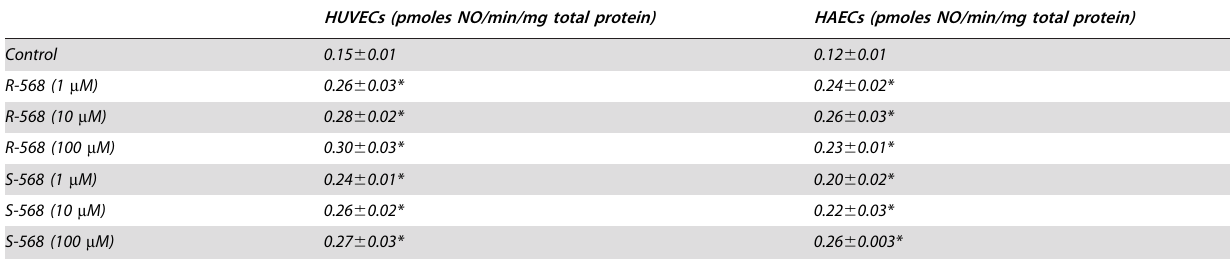
*p , 0.05 (R- and S-568 vs Control).